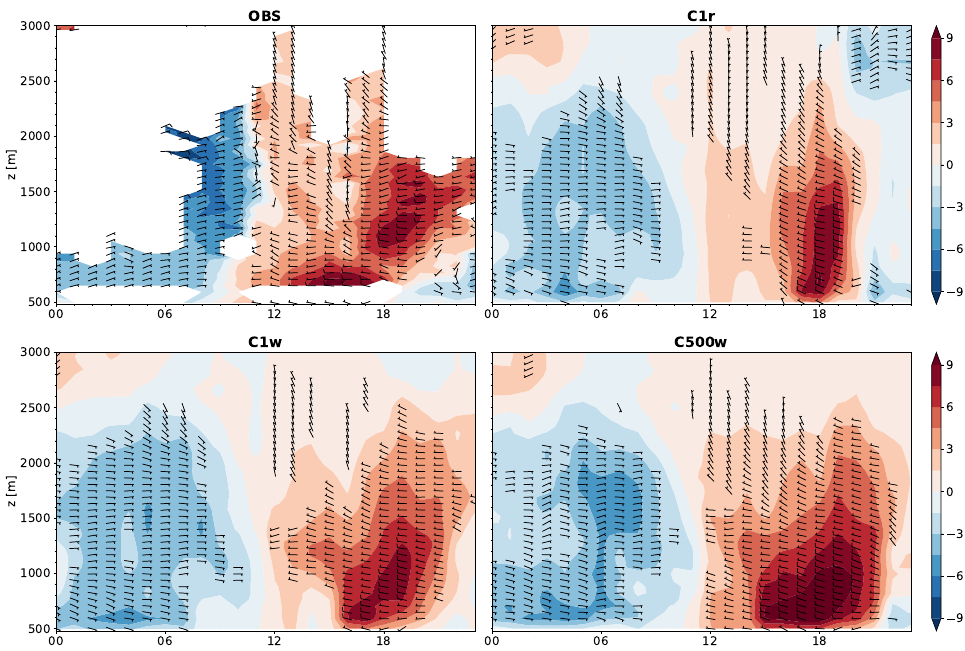
Figure 12. Time-height plot of the along-valley wind speed (shading) and wind direction (barbs) relative to the valley’s axis for the low-mode wind profiler (OBS) and three model runs for 10 September 2016.